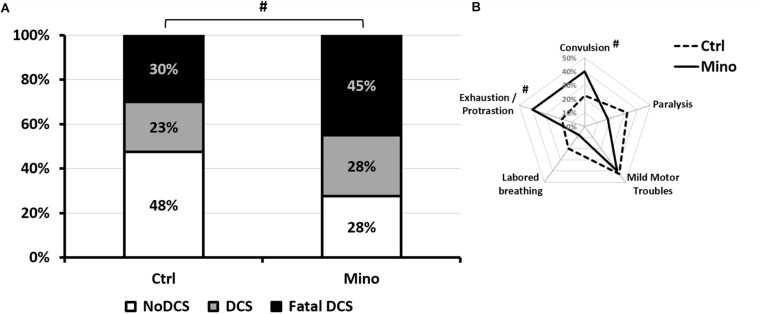
Symptoms in different groups of mice 30 min after pathogenic decompression as a function of drug treatment. (A) Histogram: The Fatal DCS status (Black blocks) encompasses mice that die in the 30 min following the end of the hyperbaric protocol. The DCS status (gray blocks) was attributed when the mice presented neurological signs in the form of paresis or paralysis of at least one limb, convulsions and/or reduced performance in the motor test for forelimbs. White blocks represent the proportion of mice that passed both grip tests and shown no clinical sign (NoDCS). (B) Radar Chart: percentage of mice displaying a type of symptom in a population, considering that a mouse can present several symptoms at the same time. Ctrl, Control mice (no active molecules); Mino, Minocycline (90 mg/kg), #Denotes p < 0.10 (trend) between groups.